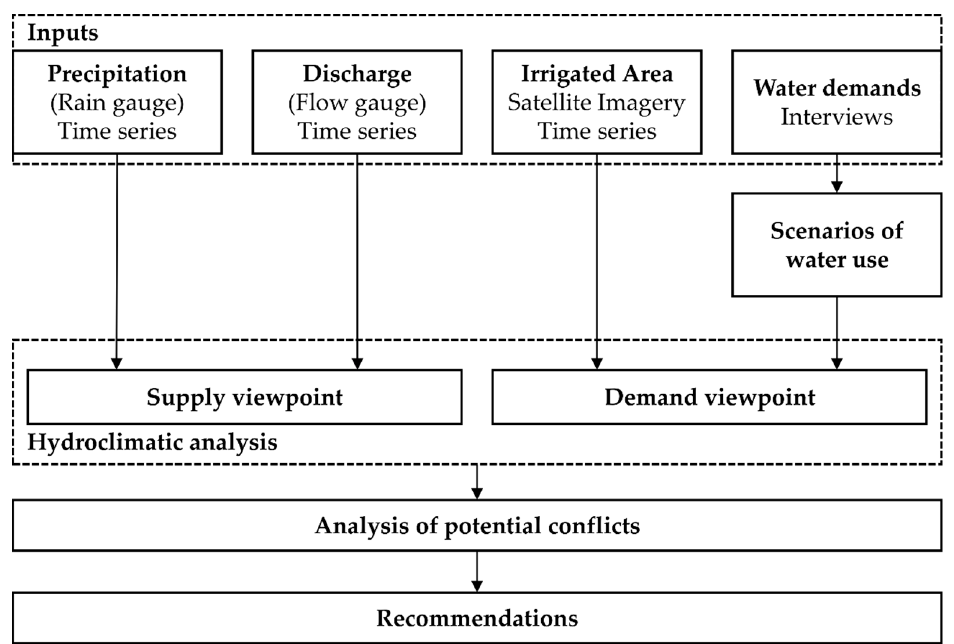
Figure 2. Flowchart illustrating the data and methods.